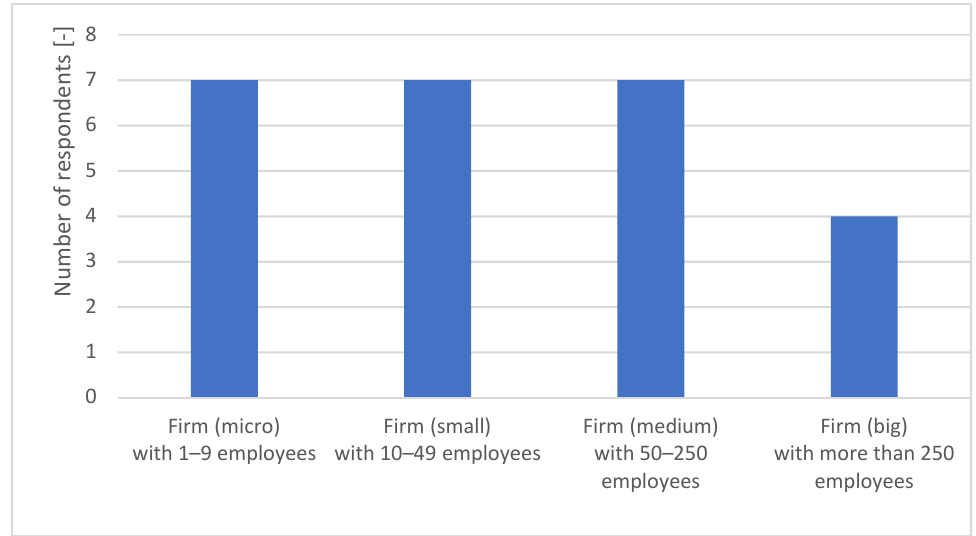
Figure 3. The size of the respondents’ companies.